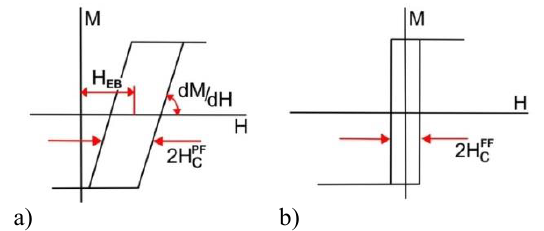
Fig.1 Typical hysteresis loops for pinned (a) and free (b) F layers and their varied parameters coercivity, H CPF , exchange bias, H EB , and tilt, dM/dH , for PF hysteresis loop (Fig.1a) and solely coercivity, H CFF , for the FF hysteresis loops.